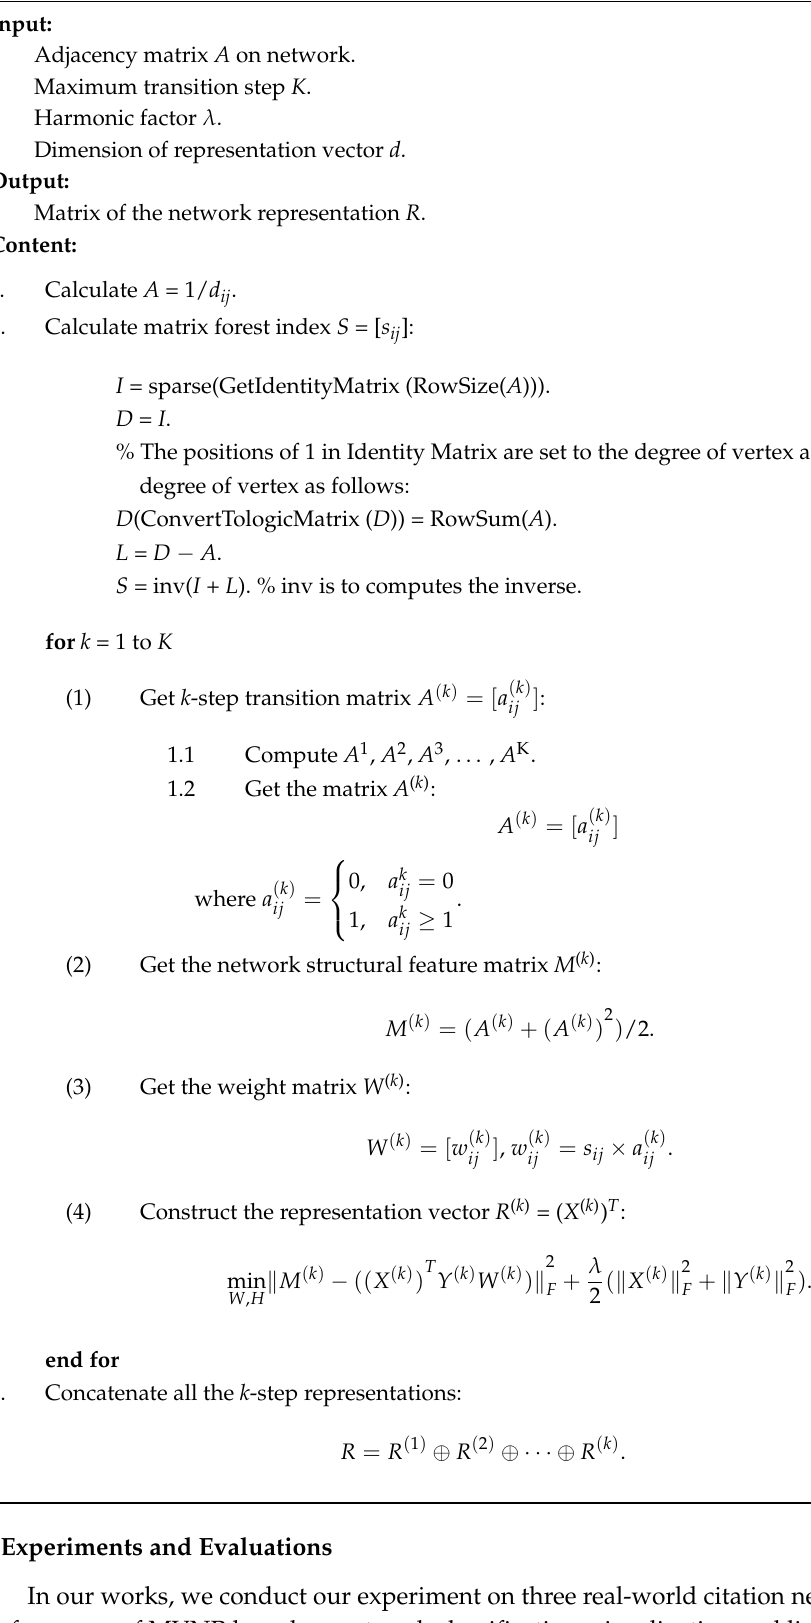
Algorithm 1 MVNR